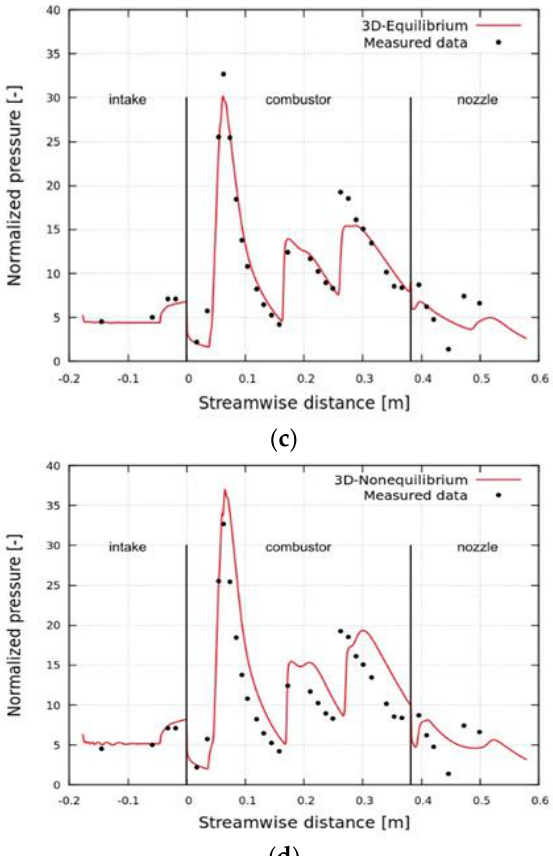
Figure 10. Distributions of normalized pressure along the bottom wall: ( a ) 2D-equilibrium case; ( b ) 2D-nonequilibrium case; ( c ) 3D-equilibrium case; ( d ) 3D-nonequilibrium case.